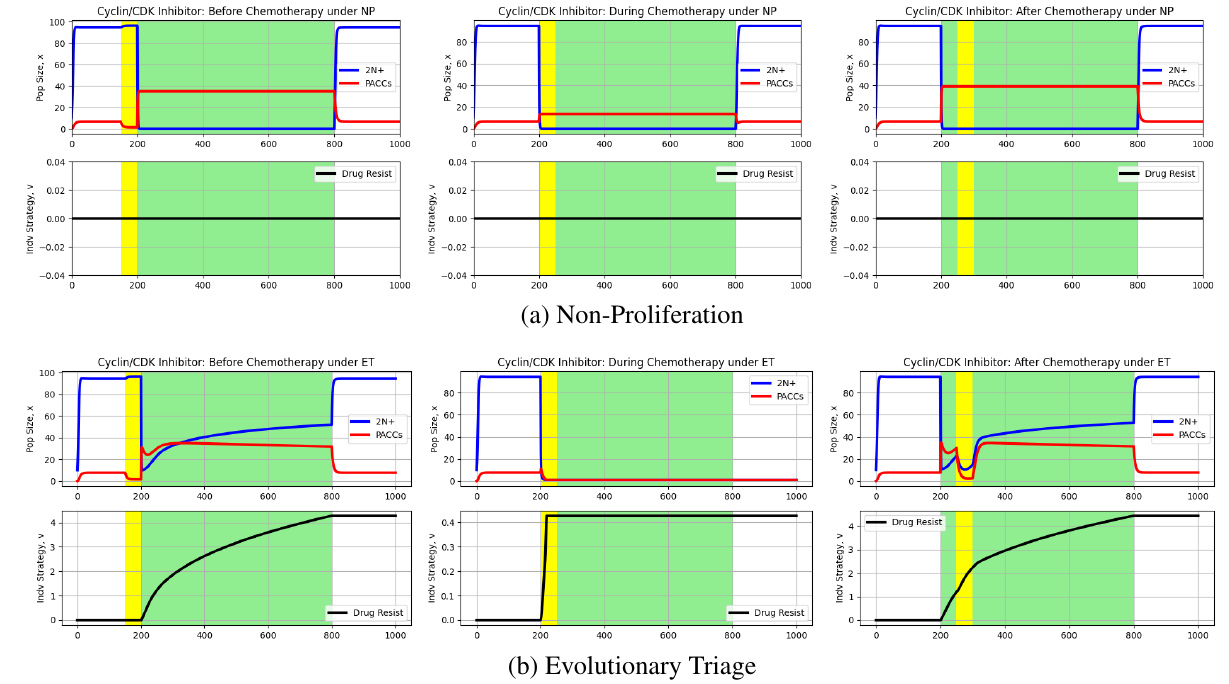
Figure 5. Effect of cyclin/CDK inhibitors on eco-evolutionary dynamics of cancer cell population. Blue and red curves depict 2N+ and PACC population dynamics, respectively, and the black curve captures the evolutionary dynamics of resistance. White and green backgrounds reflect periods without and periods with chemotherapy, respectively, and yellow backgrounds are periods with a Cyclin/CDK inhibitor. Under ET, the Cyclin/CDK inhibitor promoted extinction of the cancer cell population when administered at the same time as chemotherapy. Under NP, the Cyclin/CDK inhibitor was able to greatly reduce the PACC population when administered just before or at the same time as chemotherapy, but was ultimately unable to eradicate the